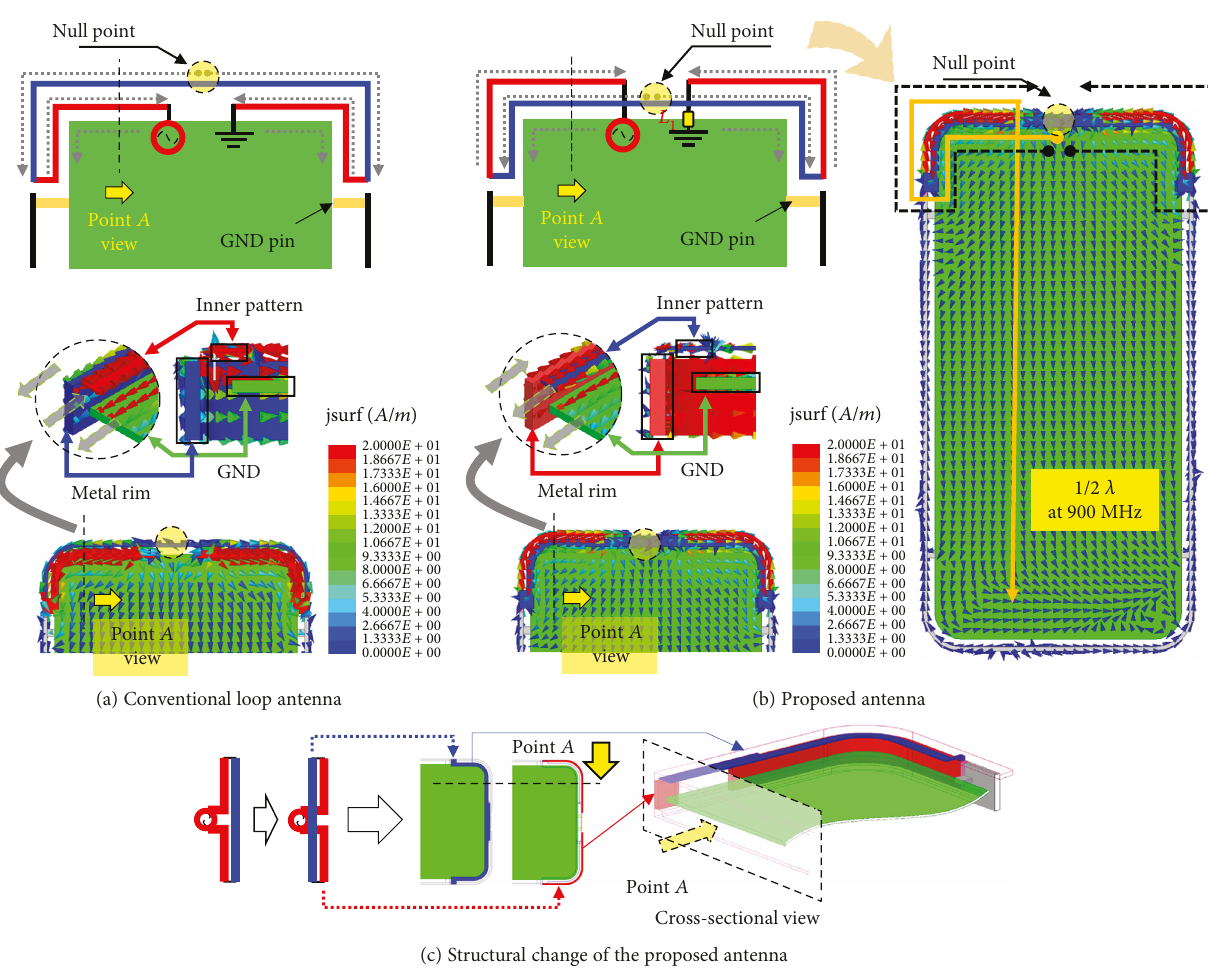
Figure 1: Proposed idea and current distribution with a first resonance at 900MHz in comparison with conventional loop